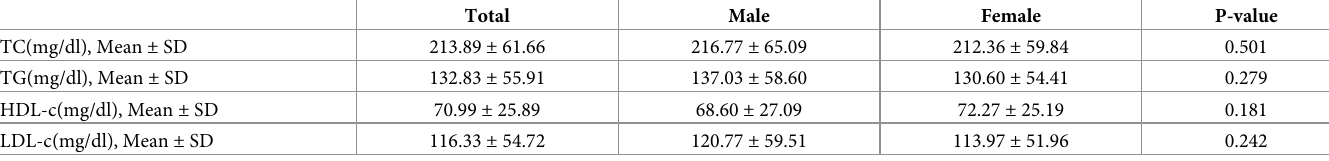
Table 2. Mean lipid levels among HIV infected adults receiving ART stratified by gender.